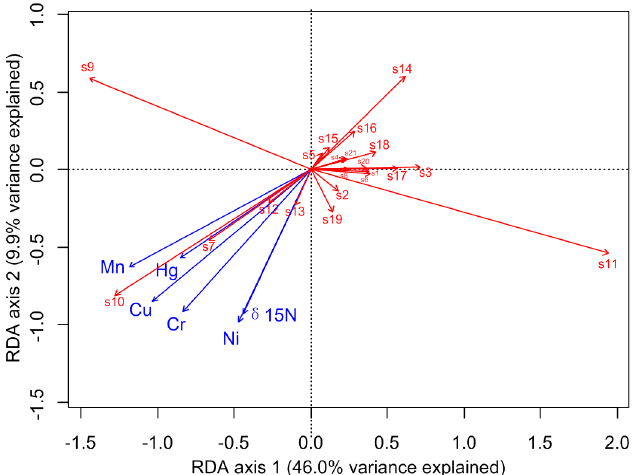
Figure 5. Plot of the redundancy analysis ordination for diatom assemblages (during ca., 1951–2010 AD). The blue arrows represent the significant ( p < 0.05) environmental variables explaining variation in the diatom assemblages, and the red arrows represent the major diatom species. s1: